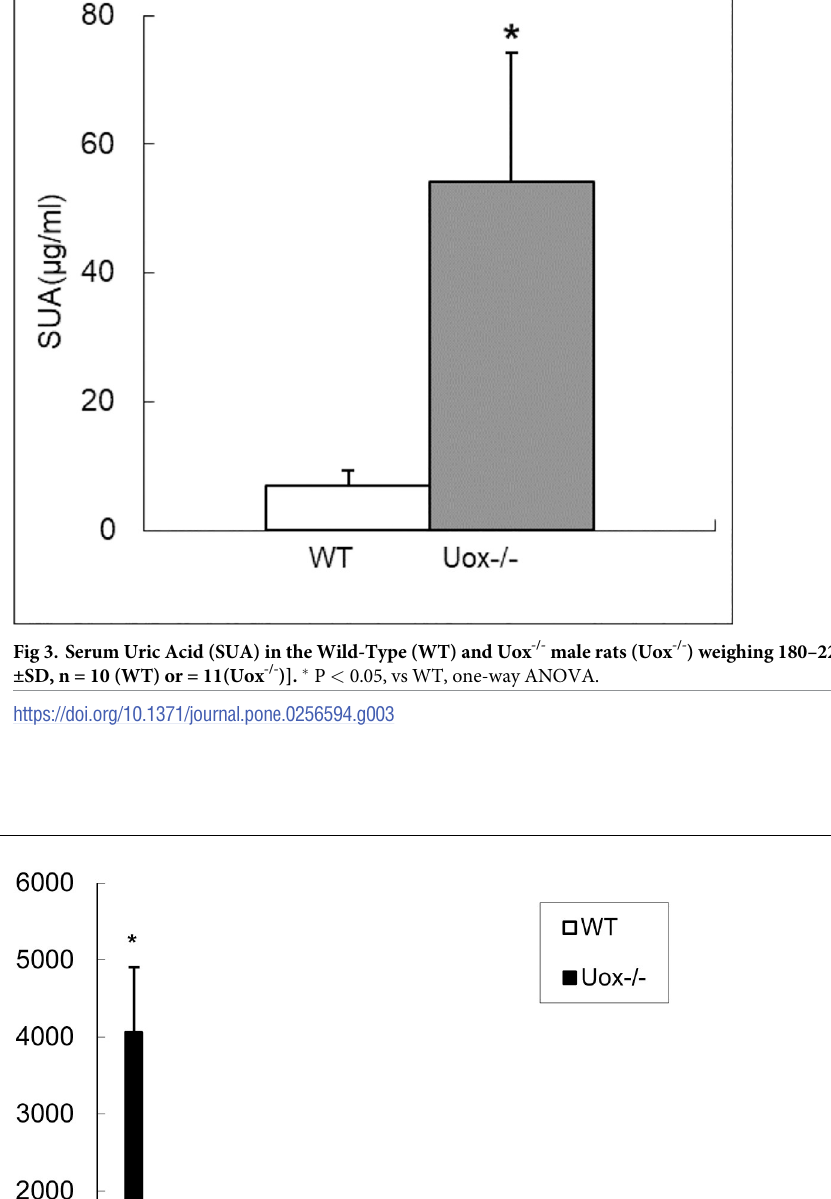
PLOS ONE | https://doi.org/10.1371/journal.pone.0256594 August 26,